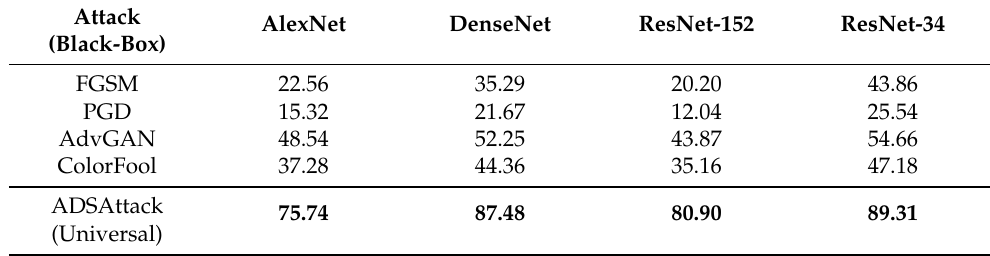
Table 4. Comparison experiments of five algorithms, including FGSM, PGD, AdvGAN, ColorFool and our ADSAttack with respect to black-box transferability—represented by attack success rate (%)—among different deep learning